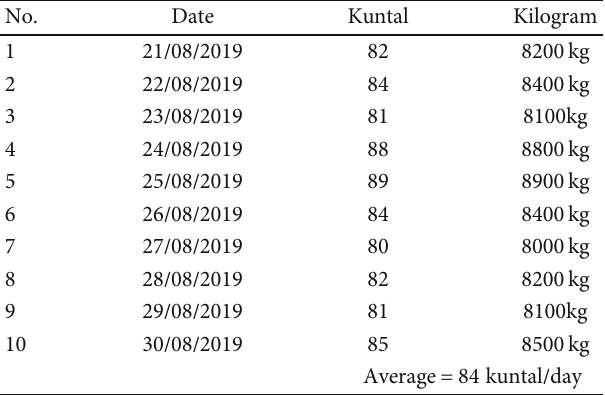
Table 4: Firewood used in Atse Fasil Campus per day for 10 consecutive days.